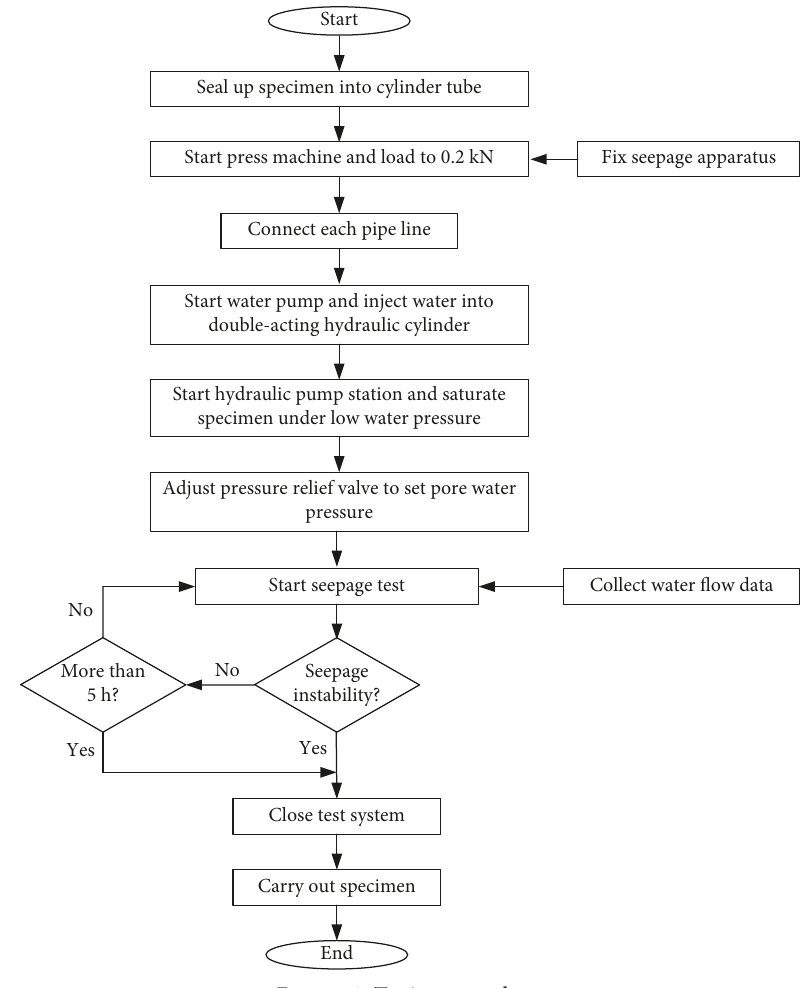
Figure 4: Testing